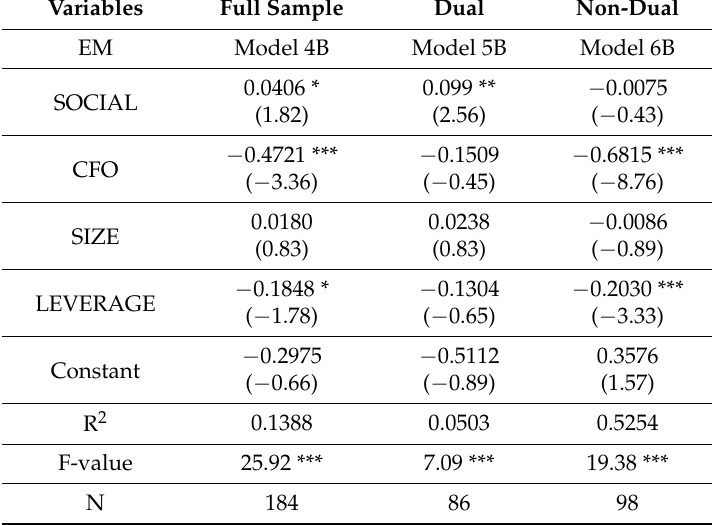
Table A2. Effects of social relationships on earnings management in presence of CEO